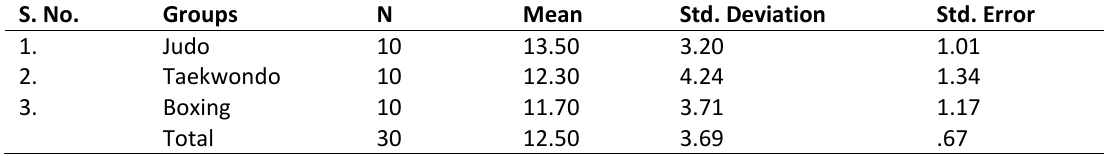
Table 9. Descriptive analysis among judo, taekwondo and boxing players on the sub-parameter game/competition S.